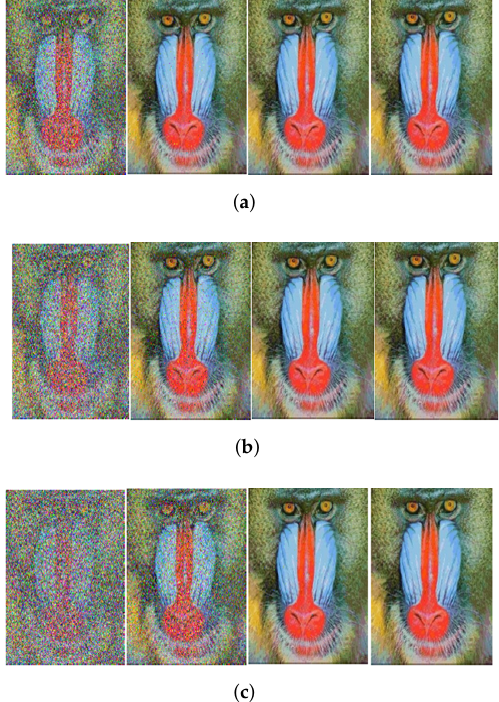
Figure 10. Received image with massive MIMO incorporated FRFT-OFDM over a Rayleigh channel, Modulated with BPSK and at SNR = 0, 10, 20, 30 dB from Left to Right for different number of users, n . ( a ) n = 10; ( b ) n = 20; ( c ) n = 50.